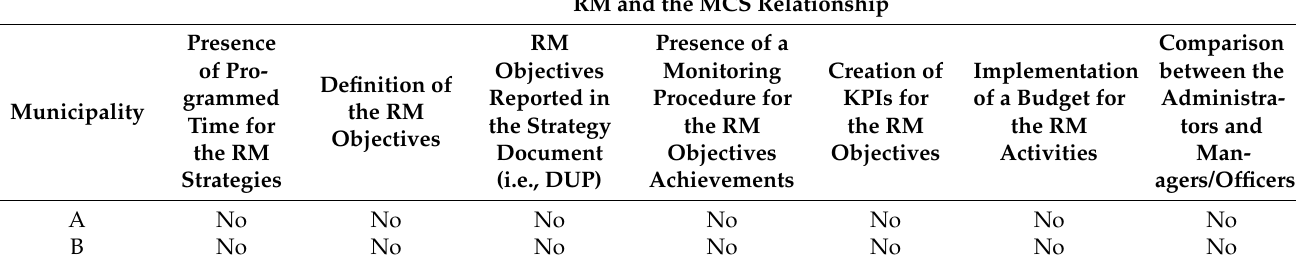
Table 4. Responses to the risk management and management control system relationship for Munici- palities A and